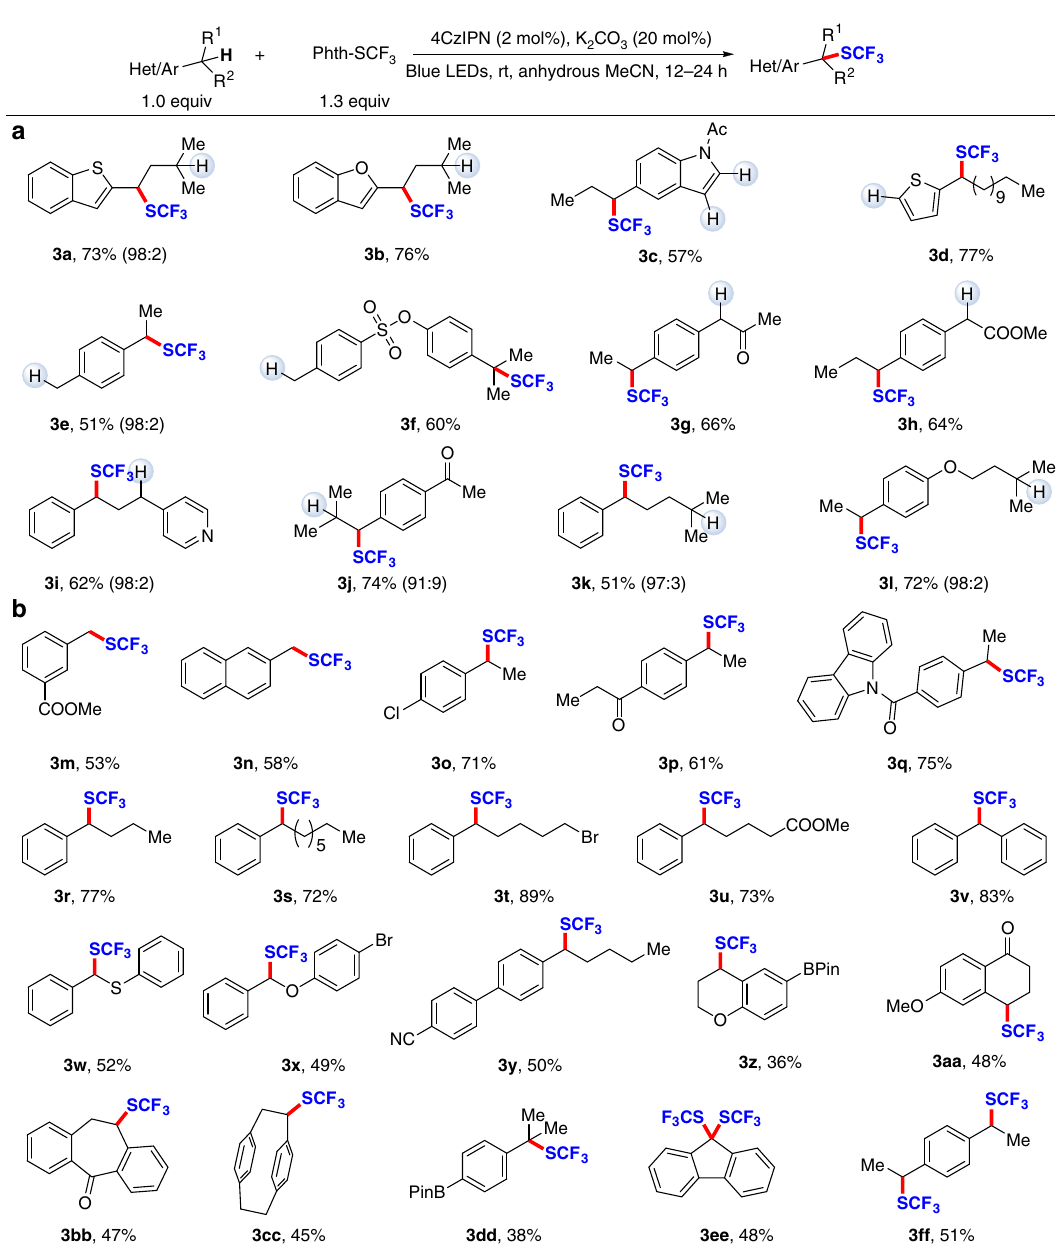
Fig. 2 The reaction scope. a Substrates with the heteroaromatic ring or competing C – H bond. b Substrates with 1°, 2°, 3° benzylic C – H bond. Yields of isolated products are given. The ratio of 3 / 3 ′ is given in the parenthesis. 3i contains a small amount of raw material 1i , due to the similar Rf